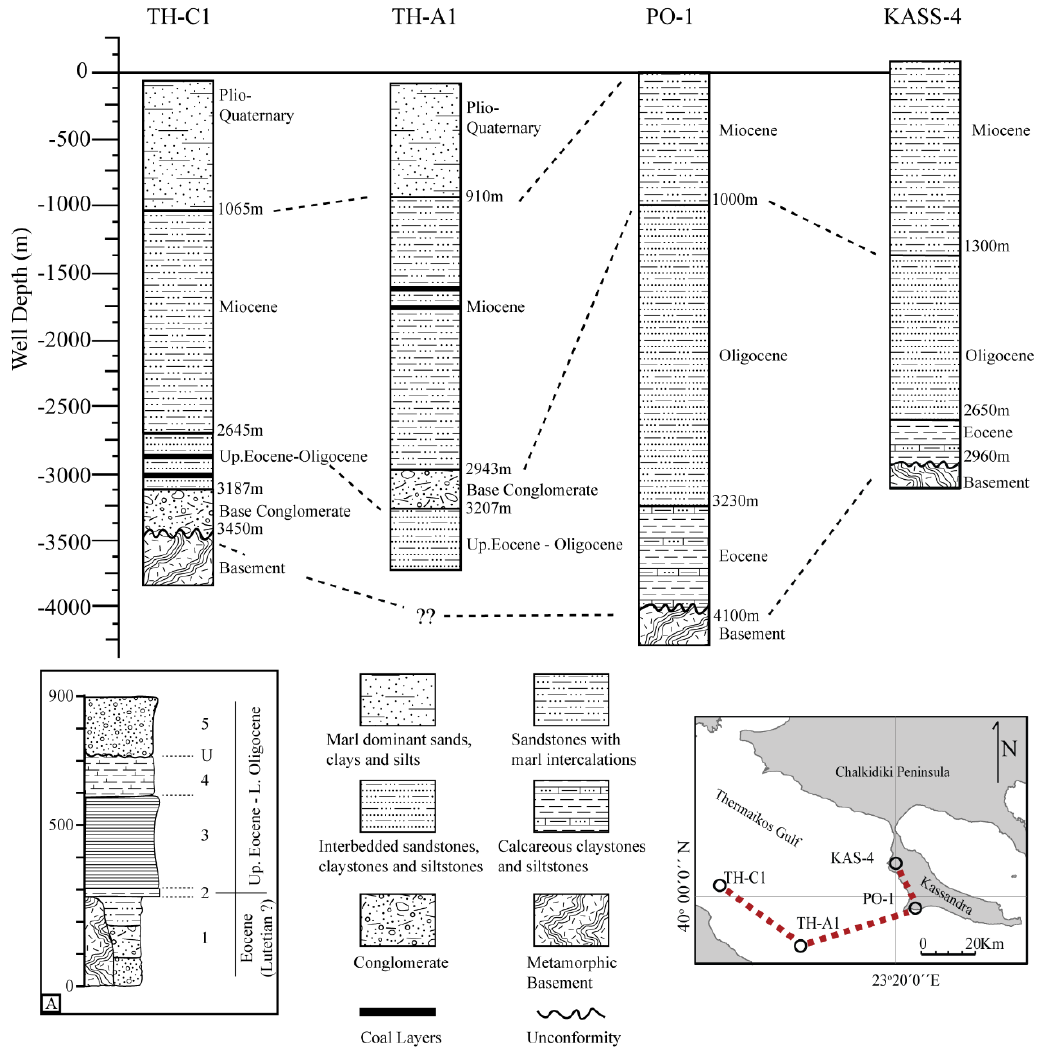
Figure 3. Schematic well correlation of four wells in the area of the Thermaikos Gulf and Kassandra Peninsula. The wells are modified after the integration of Faugères and Robert [39], Lalechos and Savoyat [40], and Aidona et al. [37]. ( A ) Synthetic stratigraphic column for the Paleogene formations in Axios basin after IFP [38]. (1) sequence of conglomerates, sands, and marls over the metamorphic basement, (2) neritic limestones, (3) marls with nummulites, (4) clay marls with ostracods, (U) unconformity, and (5) conglomerates and sandstones.